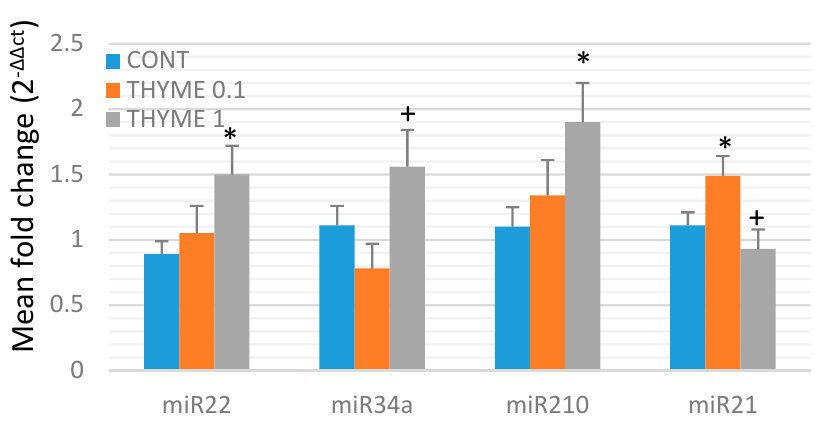
Figure 6. Relative miRNA expression of miR22, miR34a, miR210, and miR21 in rat mammary carcinomas. MiR-191-5p was selected as the internal control miRNA to normalize the cDNA levels of the samples. Data are expressed as mean ± SEM. Significant difference, * p < 0.05 versus CONT, + p < 0.05 versus THYME 0.1.